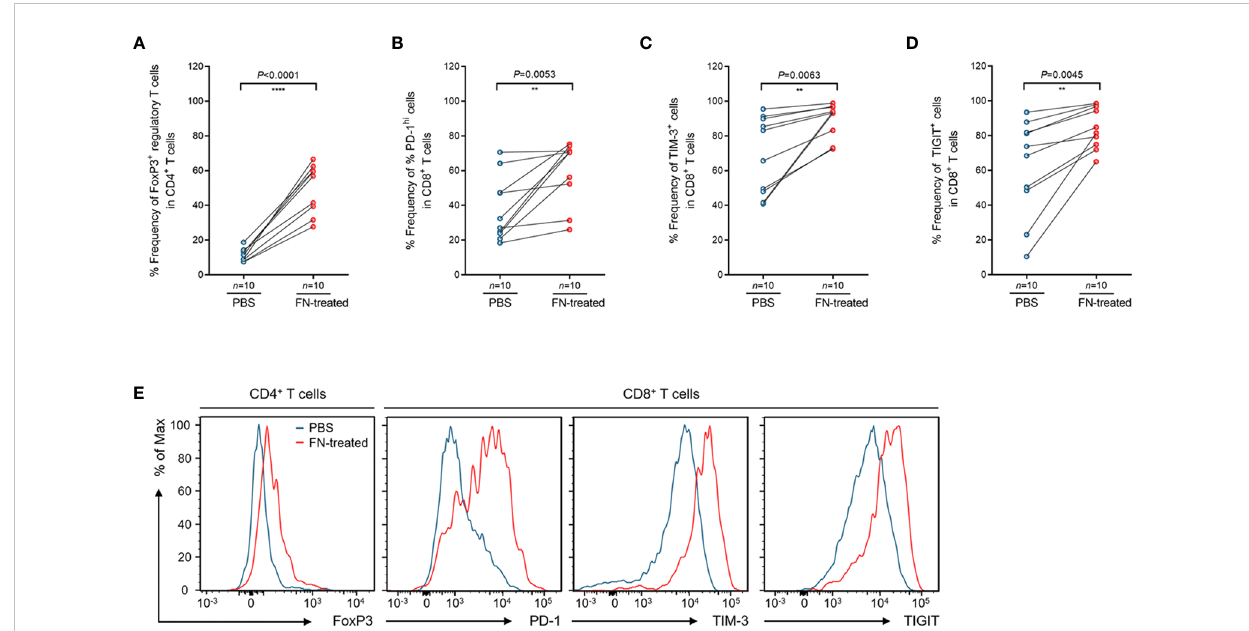
FIGURE 4 Phenotypic changes of tumor-in fi ltrating regulatory T cells and CD8 + T cells upon FN treatment. (A) Relative frequency of FoxP3 + regulatory T cells in tumor-in fi ltrating CD4 + T cells upon FN infection. (B – D) Relative frequency of PD-1 hi (B) , TIM-3 + (C) , and TIGIT + (D) cells in tumor-in fi ltrating CD8 + T cells upon FN treatment. (E) A representative histogram showing the expression of FoxP3, PD-1, TIM-3, and TIGIT for tumor-in fi ltrating T cells. Error bars indicate SEM. Statistical tests: ** P < 0.01, **** P <